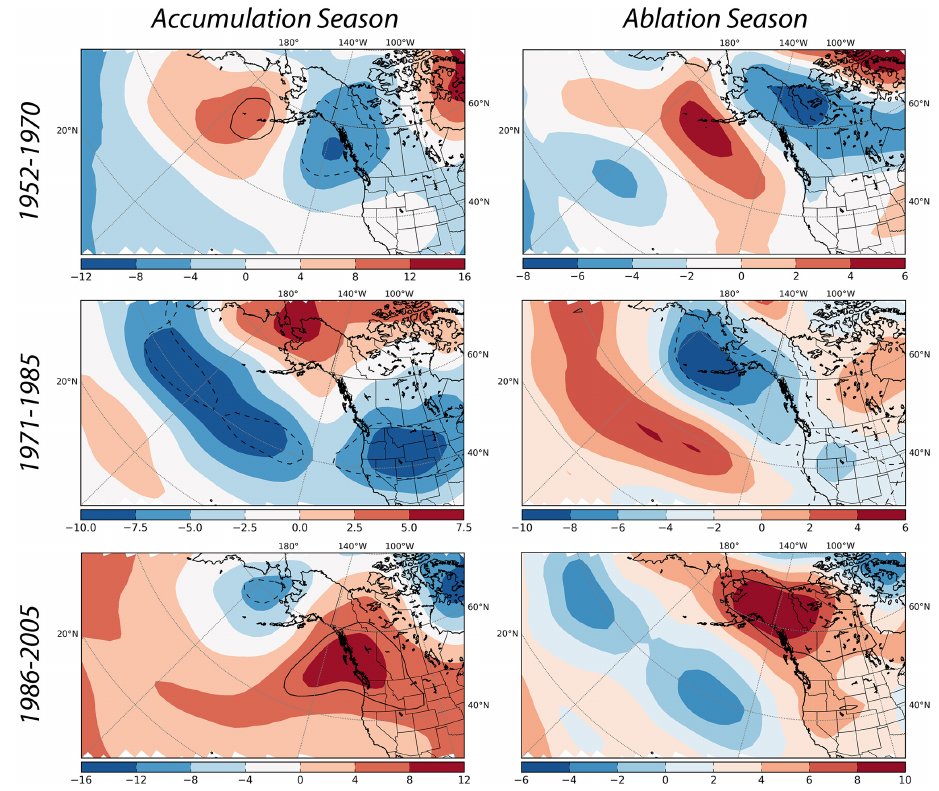
Figure 12. Geopotential height (700hPa) anomalies (m) for the accumulation and ablation seasons. Color scale shows magnitude of anomaly. Data for the period 1952–2005 define the mean fields. Dashed and solid contours respectively denote negative and positive anomalies that are significantly different ( p < 0 . 05) from the mean at a given grid point. Reanalysis data were downloaded from the National Oceanographic and Atmospheric Administration’s Earth System Research Laboratory